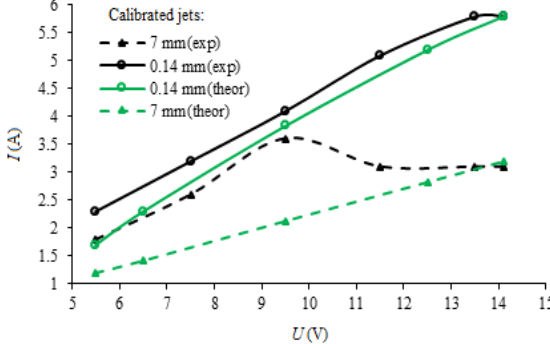
Figure 8. The dependence of the change in the current consumption rate of the EFP on the voltage supplied to the pump by the external control unit when using calibrated jets with the following section diameters (0.14 mm…7